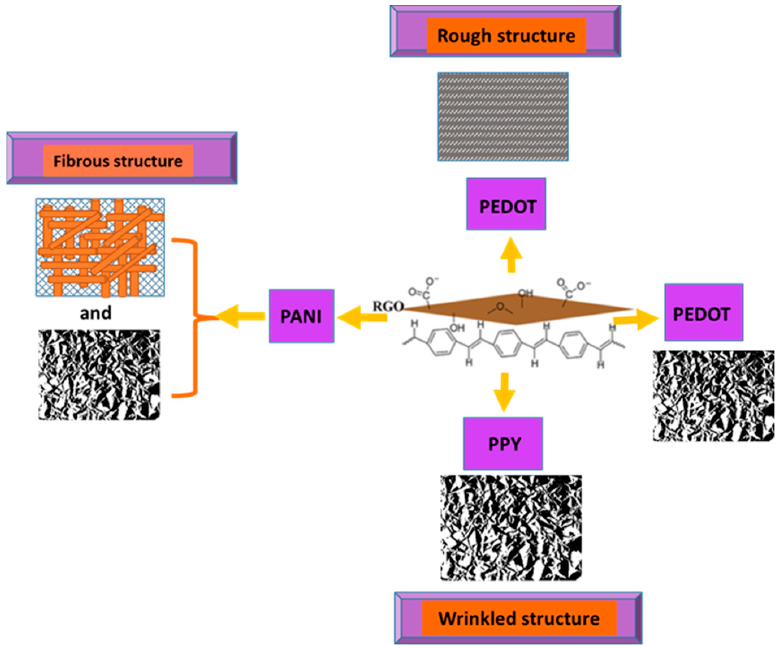
Figure 11. CP/RGO composites with different surface morphology, depending on the CP structure.